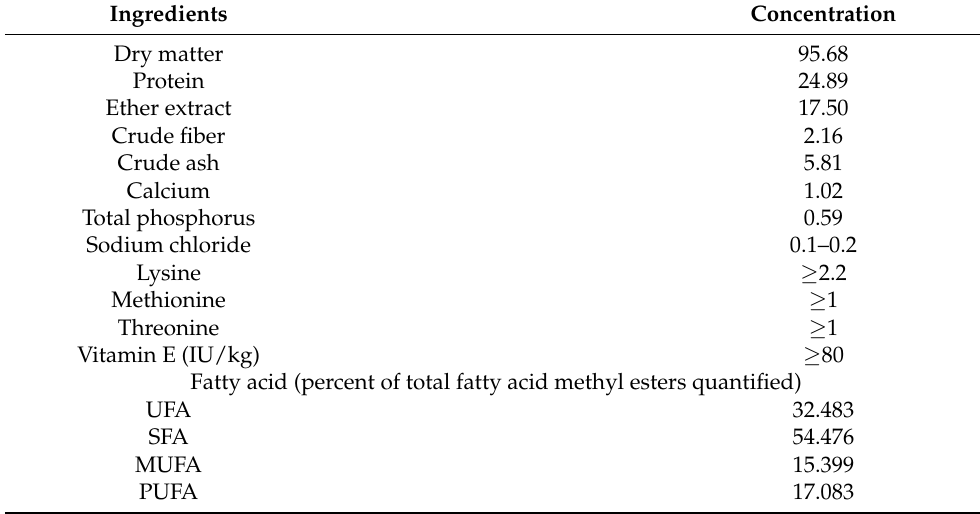
Table 1. Chemical composition of lamb milk replacer (air-dried sample basis,